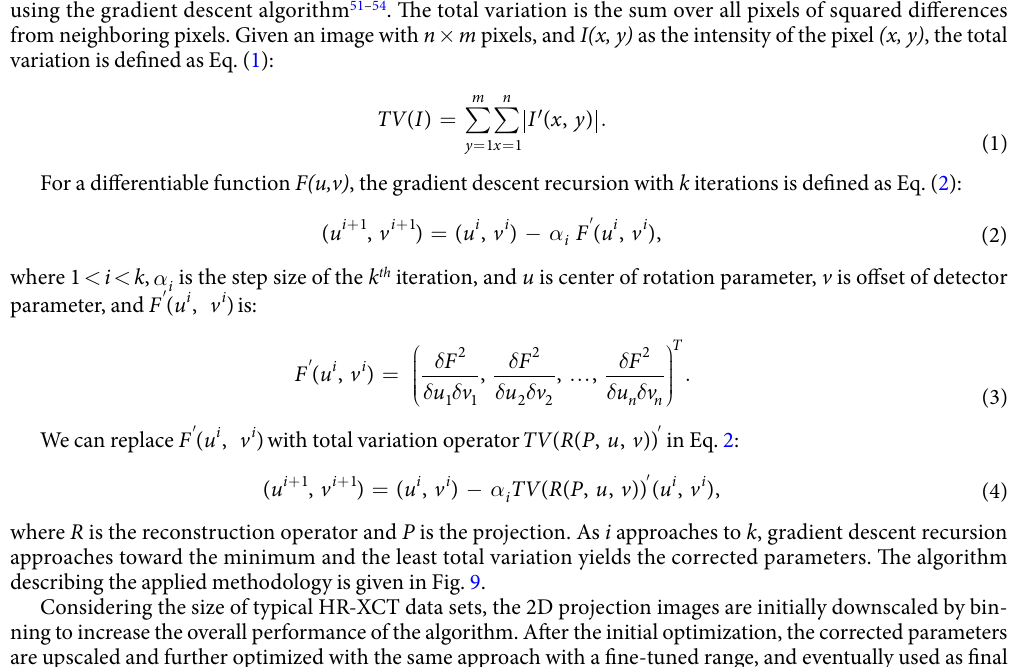
Center of rotation and offset of detector correction.